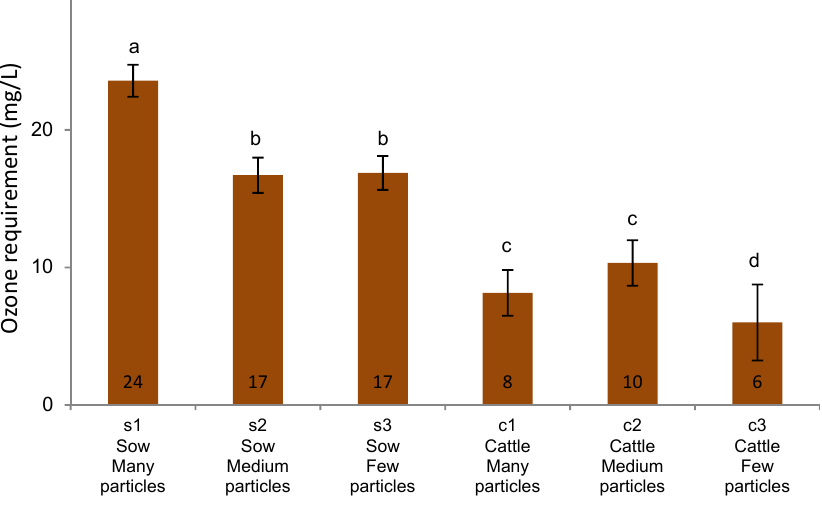
Figure 4. Ozone amount required to lower the gaseous H S concentration above different 2 S. The error bars indicate standard deviations. Statistically equal manures to <0.05 ppm H 2 results are indicated by the same letters above the